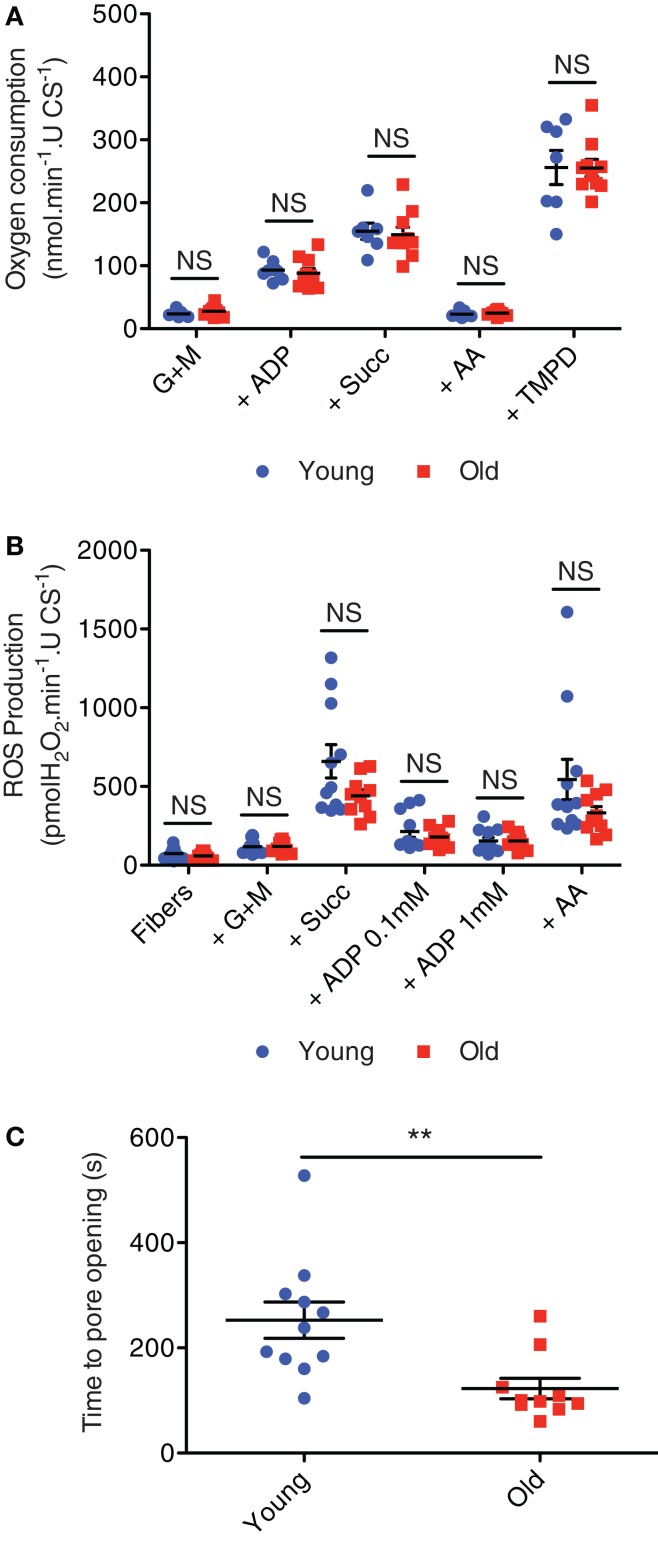
Mitochondrial respiration (A), hydrogen peroxide emission (B), and sensitivity to permeability transition following a calcium challenge (C) in saponin-permeabilized myofibers prepared from vastus lateralis muscle biopsies obtained from recreationally active healthy young (24 ± 1 years; mean ± SE) and older (71 ± 2 years) men. Figures are reproduced with permission from Gouspillou et al. (2014b). G + M = glutamate + malate; Succ = succinate; AA = antimycin A, TMPD = artificial electron donor. **P < 0.05 versus old.